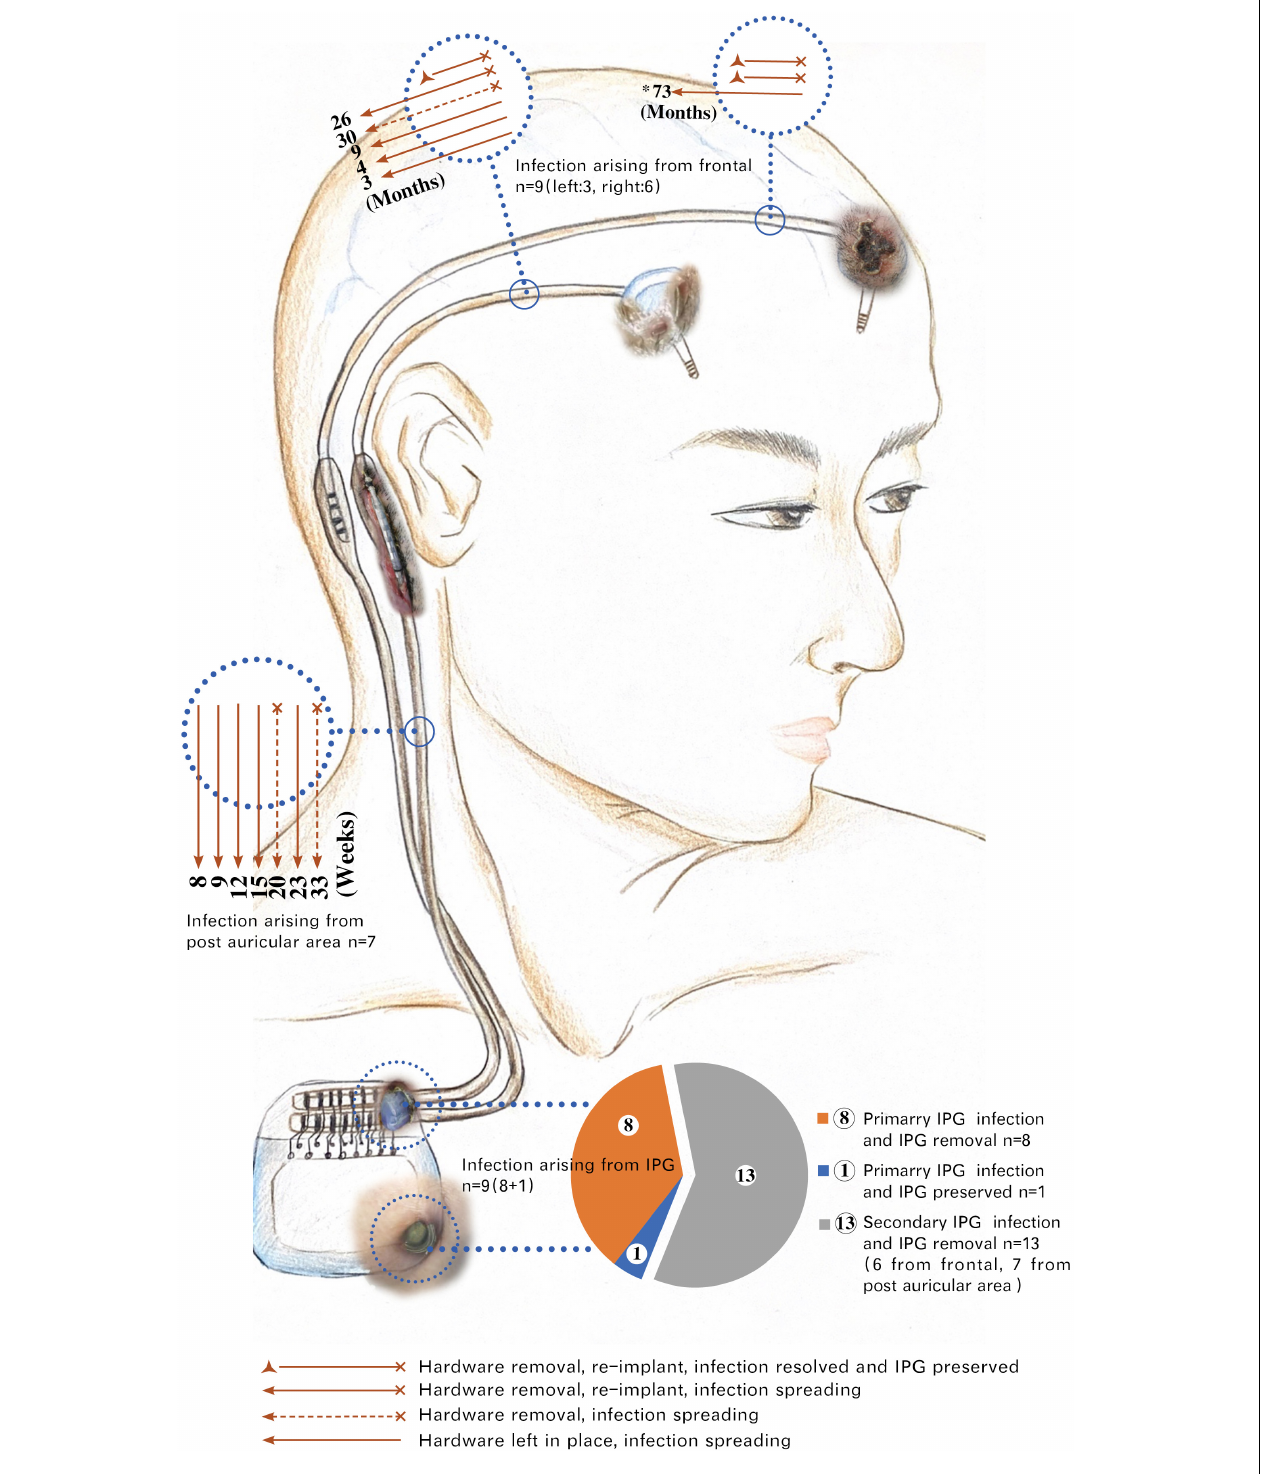
FIGURE 3 | Spreading of hardware-related infections in group A. *73: The infection arising from the left head spread to the right postauricular area 73 months post-diagnosis of infection. This patient underwent five times of local incision debridement (including two times of rotational flap) before intracranial lead removal. Months: Time interval of infections spreading from frontal to postauricular area counted by months. Weeks: Time interval of infections spreading from postauricular area to infraclavicular region (IPG pocket) counted by weeks. Six infections of frontal origin and seven infections of postauricular origin finally spread to IPG. Among a total of 22 IPG infections, 21 were removed, with only 1 IPG remaining at a place after being sterilized with ethylene oxide. The exposed parts of the hardware in the picture were taken from real photos. IPG, implantable pulse generator.